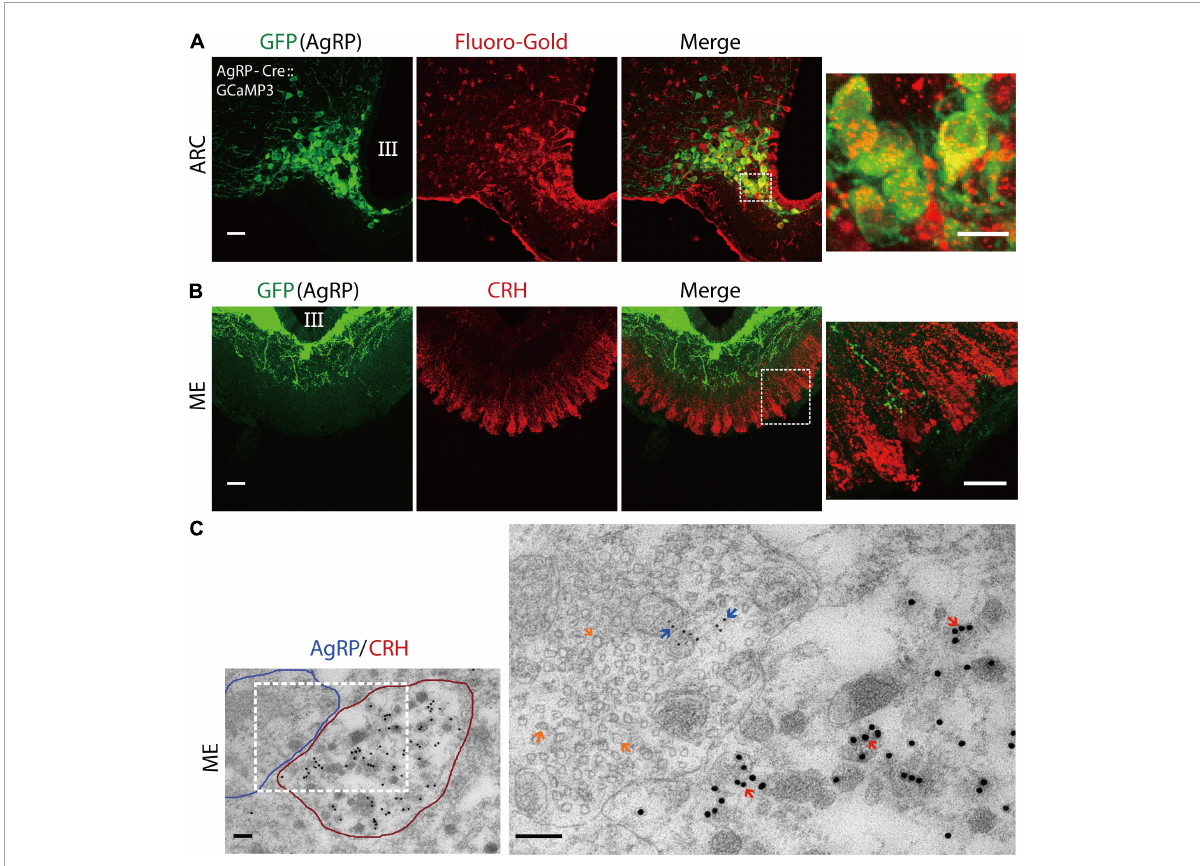
FIGURE1 Agouti-related peptide (AgRP) neurons project to corticotropin-releasing hormone (CRH) neuronal terminals in the median eminence. (A) The retrograde tracer Fluoro-Gold was peripherally delivered in AgRP-Cre:GCaMP3 mice. Confocal image showing AgRP neurons in the arcuate nucleus (ARC) stained with an anti-GFP antibody (for GCaMP3; green) and anti-Fluoro-Gold antibody (red). The dotted boxed area indicates higher magnifications image. Scale bars, 40 and 10 µ m (box). (B) Confocal image showing anti-GFP (green) and anti-CRH (red) immunoreactivity in the median-eminence (ME). Higher magnification image indicated by box shows AgRP and CRH neuronal axon terminals in the external layer of the ME. Scale bars, 40 and 10 µ m (box). (C) Double immuno-electron microscopic images showing an AgRP nerve terminal (outlined in blue) contacting a CRH neuronal terminal (outlined in red) in the ME of wild-type mice. Note that the AgRP neuronal axon terminal makes direct contact to the axon terminal of the CRH neuron. Inset box image shows higher magnification image. AgRP immunoreactivity (6-nm gold particle) indicated by blue arrow and CRH immunoreactivity (18-nm gold particle) indicated by red arrow in the external layer of the ME. Large dense-core vesicles indicate CRH-containing vesicles, while small clear vesicles marked by orange arrows in AgRP neuronal terminal indicate gamma-aminobutyric-acid (GABA)-containing vesicles. Scale bars, 500 and 200 nm, respectively. III, third